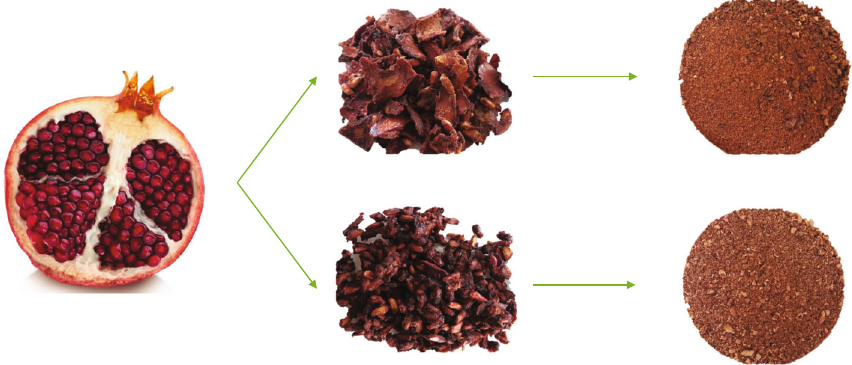
Figure 2: Visual aspect of the dried and ground pomegranate by-products: (a) peels and (b)